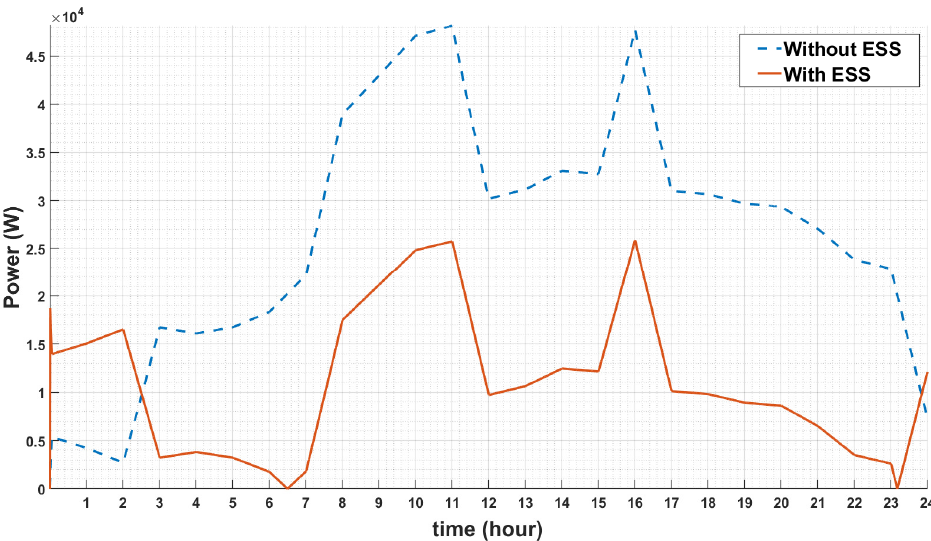
Figure 20. Maximum power of the MG with/without ESS.